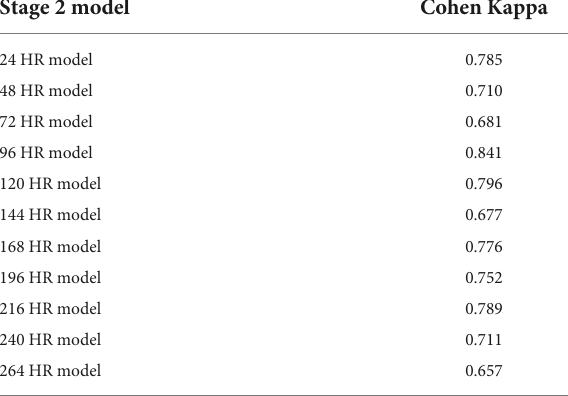
TABLE 5 Analysis of Kappa values in 11 models of Stage